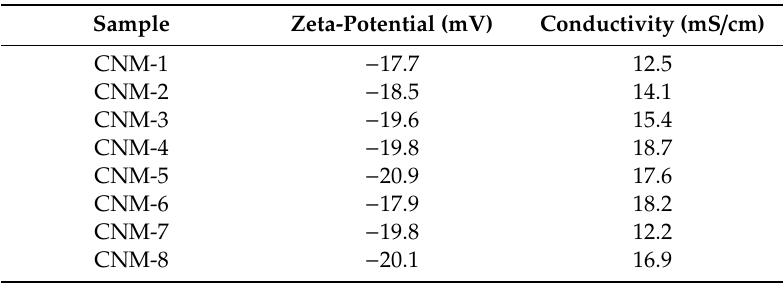
Table 2. Zeta-potential values for magnetic NCs in PBS at pH 7.4.